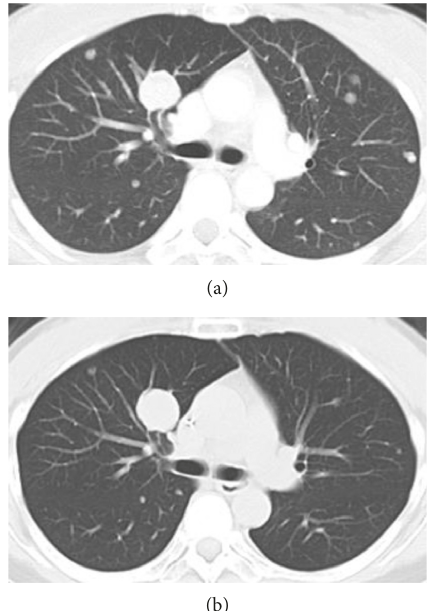
Figure 4: Computed tomography findings. (a) After four courses of IFM/DXR. (b) After 31 months of pazopanib administration. It was classified as no change by the RECIST criteria; however, slight tumor reduction was observed after 31 months of pazopanib administration.